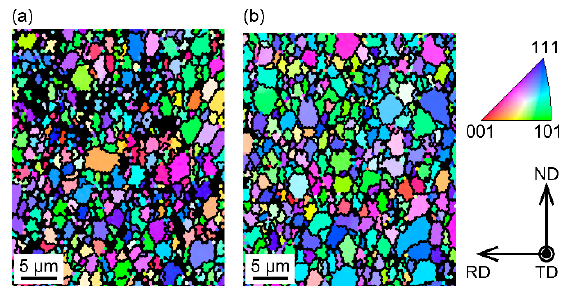
Figure 8. IPF maps of the chip specimens after heat treatment at 500 °C for ( a ) 1 min and for ( b ) 5 min.